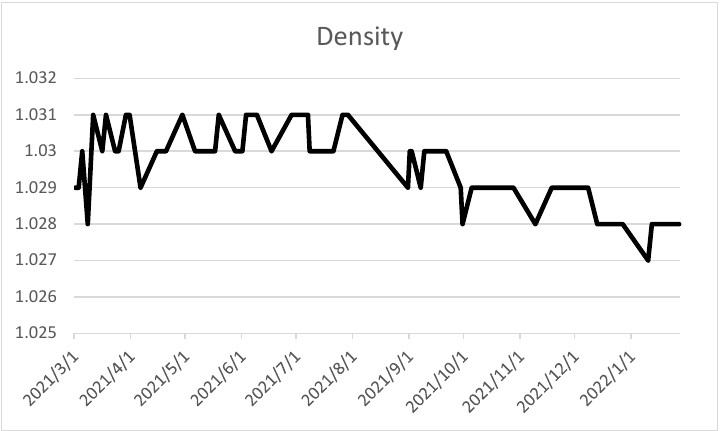
Figure 8. Salt concentration results from the South basin Barcelona port water. Source: The au- thors.